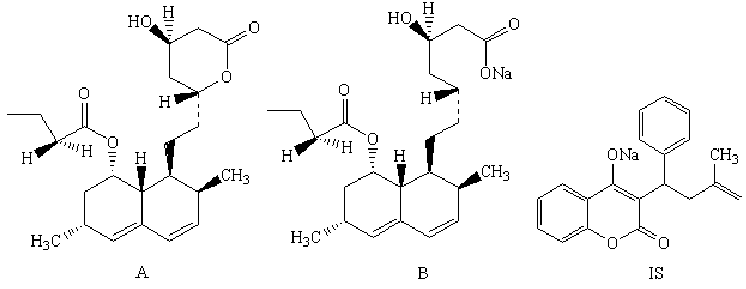
Figure 1. A, B and IS are the chemical structures of lovastatin, lovastatin acid and warfarin